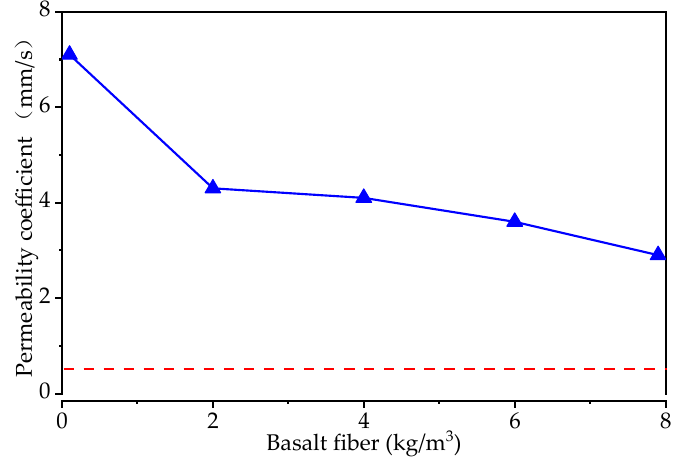
Figure 9. The permeability coefficient of pervious concrete with different levels of basalt fiber content.